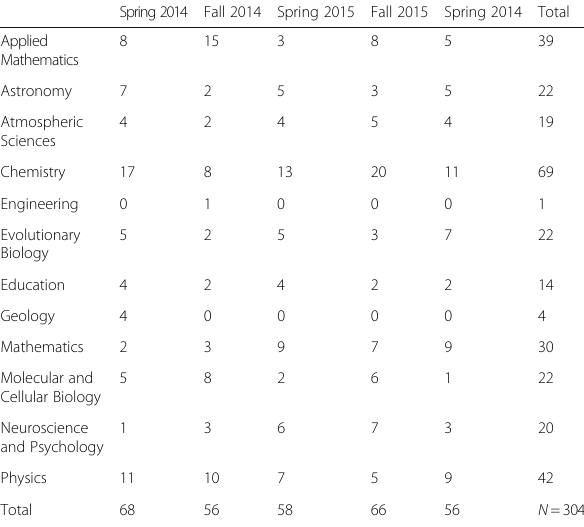
Table 1 Distribution of the study participants by semester and by